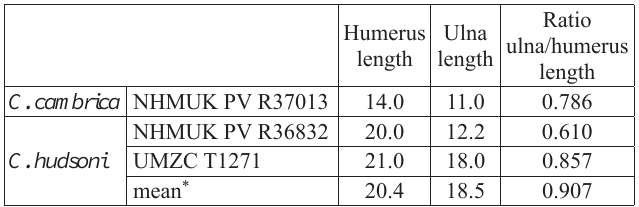
Table 2. Measurements (in mm) of Clevosaurus cambrica (NHMUK PV R37013), Clevosaurus hudsoni (NHMUK PV R36832, UMZC T1271, * specimen measured by Fraser 1988: 157, table 2, 3); note that Fraser (1988) used isolated bones without a noted registration number to compile the mean given here.